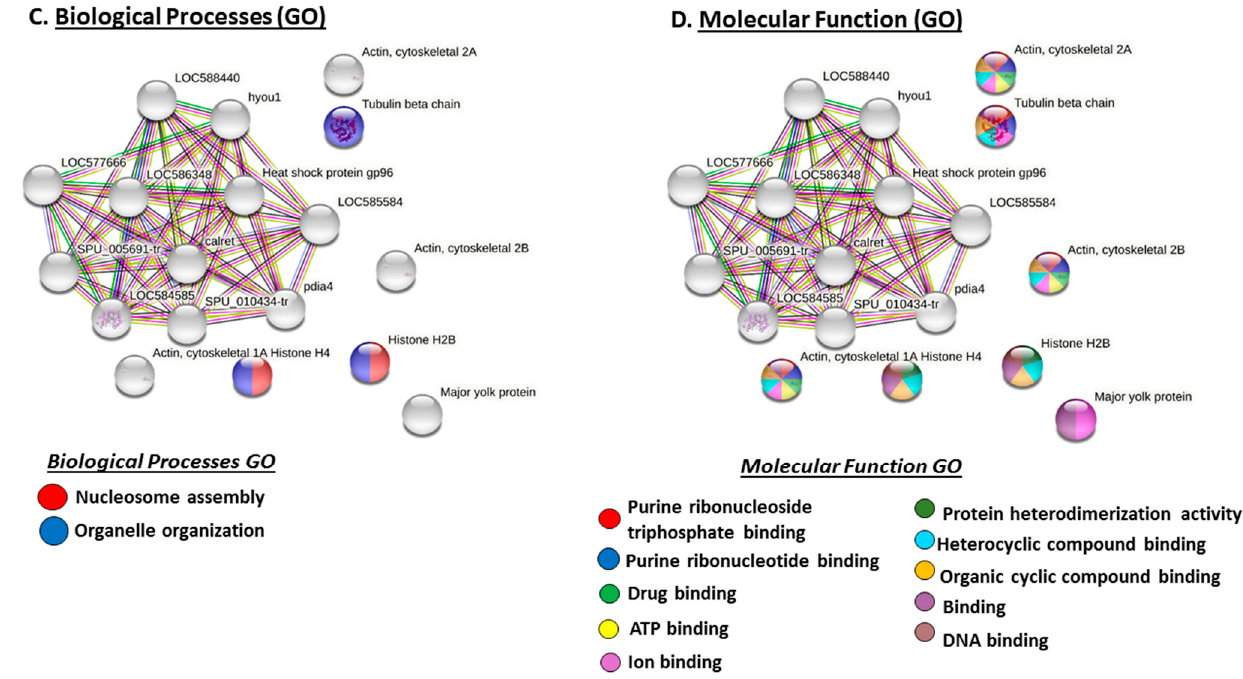
Figure 4. Protein–protein interaction networks of deiminated proteins identified in purple sea urchin coelomic fluid EVs. ( A ) Protein networks for deiminated proteins in purple sea urchin EVs based on known and predicted interactions in Echinoidea, using STRING analysis. Coloured nodes represent query proteins only. Coloured lines connecting nodes show the type of interactions between the nodes of the networks based on known interactions, predicted interactions, and others (including text-mining, co-expression, and protein homologue); colour code legend is provided in the figure. PPI enrichment p -value for the protein network is 1.11 × 10 − 16 . ( B ) KEGG pathways identified from STRING analysis for the deiminated protein candidates in purple sea urchin EVs. ( C ) Gene Ontology (GO) Biological processes identified from STRING analysis for deiminated protein candidates in purple sea urchin EVs. ( D ) GO Molecular functions identified from STRING analysis for deiminated proteins candidates in purple sea urchin EVs. Protein names of hits listed in the tables are presented in the figures; additional interacting proteins are: LOC588440 = dnaJ homolog subfamily B member 11; LOC577666 = dnaJ homolog subfamily C member 1; LOC584585 = endoplasmic reticulum chaperone BiP; hyou1 = heat shock protein 70 family member; LOC586348 = uncharacterised protein(Calnexin-like); SPU_005691-tr = Protein disulfide- isomerase; SPU_010434-tr = annotation not available (part of calriticulin protein network); pdia4 = Protein disulfide- isomerase A4.